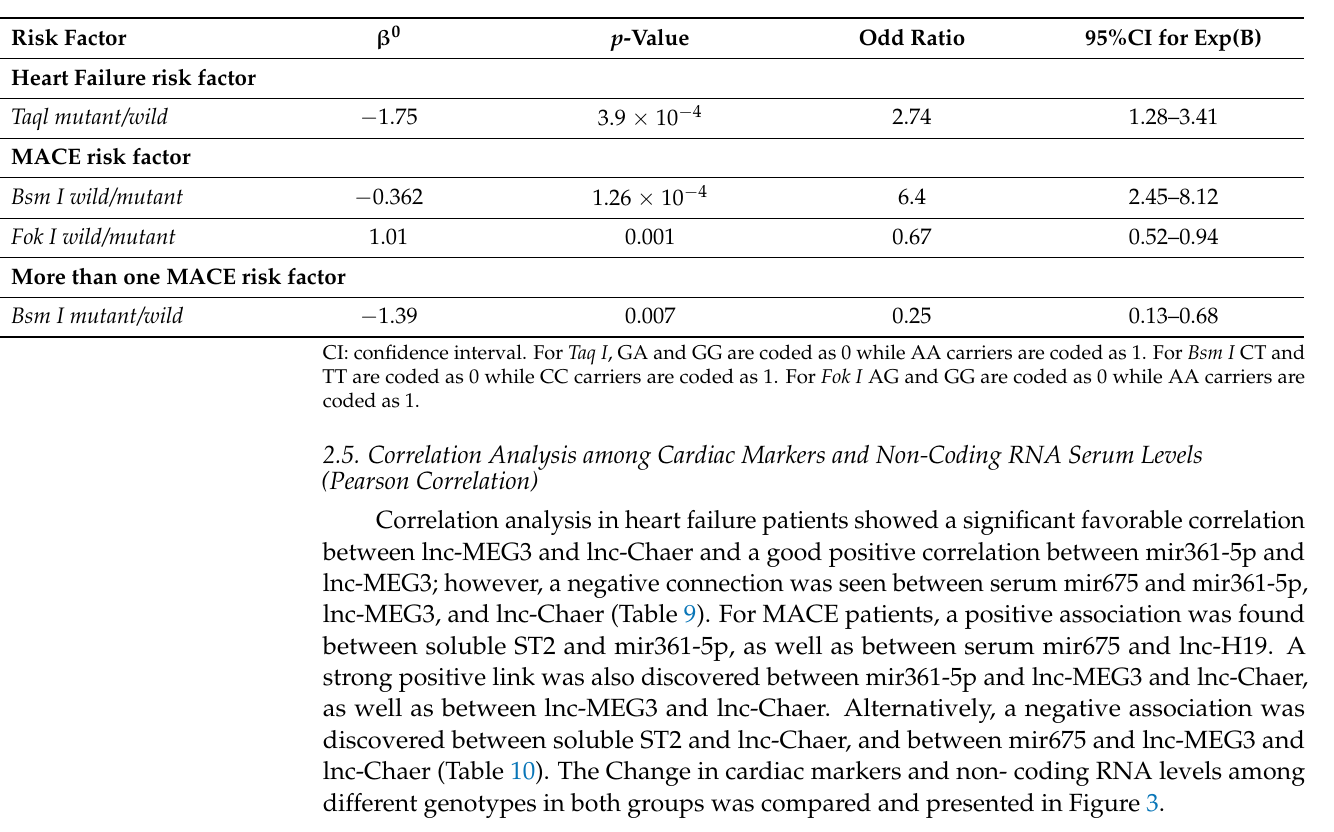
Table 8. Risk factors for heart failure and MACE occurrence by binary logistic regression analysis.